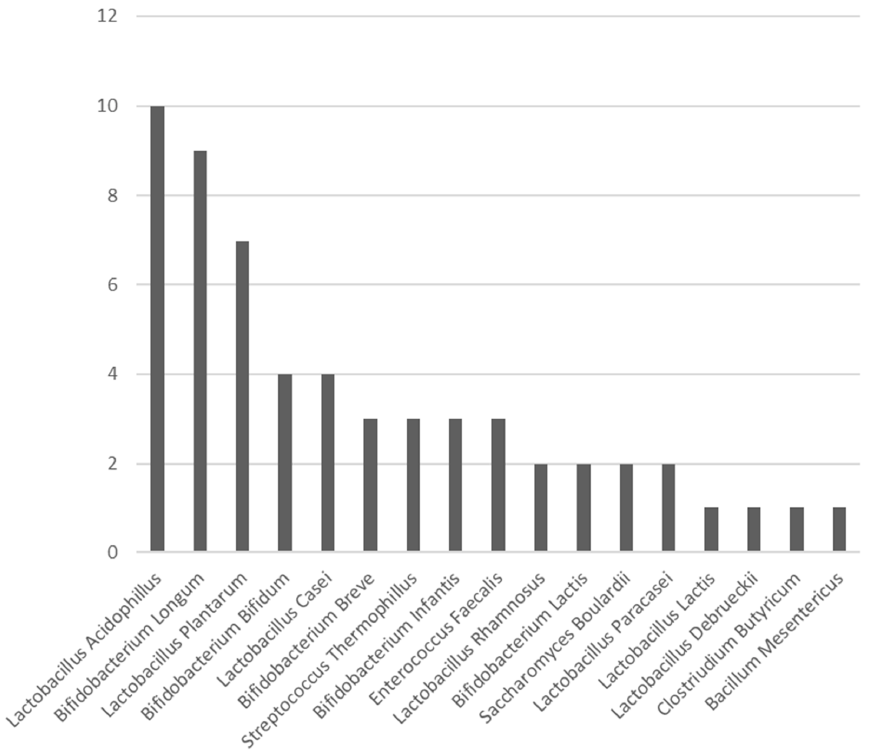
Figure 2. Bar chart exhibiting the number of times each probiotic species was used in the RCTs included in this study. Table 4. Probiotic composition and the number of probiotic strains used in each RCT included in this study. Study